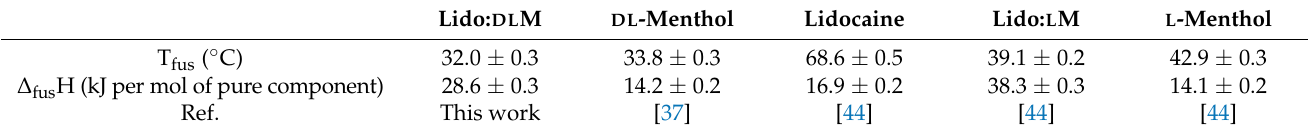
teristics of lidocaine, racemic menthol, enantiopure menthol, and L -menthol-based